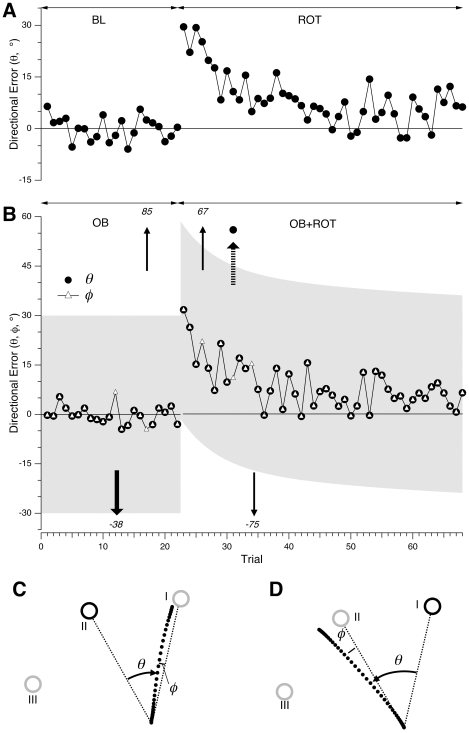
Directional error of two representative CTL subjects in a series of trials in each task condition.(A) Directional error vs. trial number in the baseline (BL) and rotation (ROT) conditions for a CTL subject in group I. Error θ is the angle, in degrees, between target and cursor directions (see Fig. 2C). A 30° rotation was imposed at trial 23. (B) Directional error (θ; filled circles) and adjusted directional error (φ; open triangles) vs. trial number in the one-back (OB) and dual task (OB+ROT) conditions for a group III CTL subject. The trials shown are a portion of a testing session. Arrows indicate instances where θ differed from φ; such values of θ are indicated in text near the arrows, because they fall outside the range shown in this plot. Grey shaded regions indicate range of plausible directional errors (see text). (C) Cursor path for trial 12 (wide downward arrow in Fig. 3B), illustrating the calculation of adjusted directional error (φ ) in an OB trial. The current target is I (grey open circle), while the previous target is II (black open circle). Because of the OB condition, the correct target for the movement is II. While θ is large (outside the range of plausible errors), φ is small, indicating that the subject likely selected target I (target selection error). (D) Cursor path for trial 31 (wide dashed upward arrow in Fig. 3B), illustrating the calculation of adjusted directional error (φ) in an OB+ROT condition. The current target is II (grey open circle), while the previous target is I (black open circle). The correct target for the movement is I. θ is large (greater than the separation between targets), while φ is within the range expected during rotation learning. This indicates that the subject likely (incorrectly) selected target II.